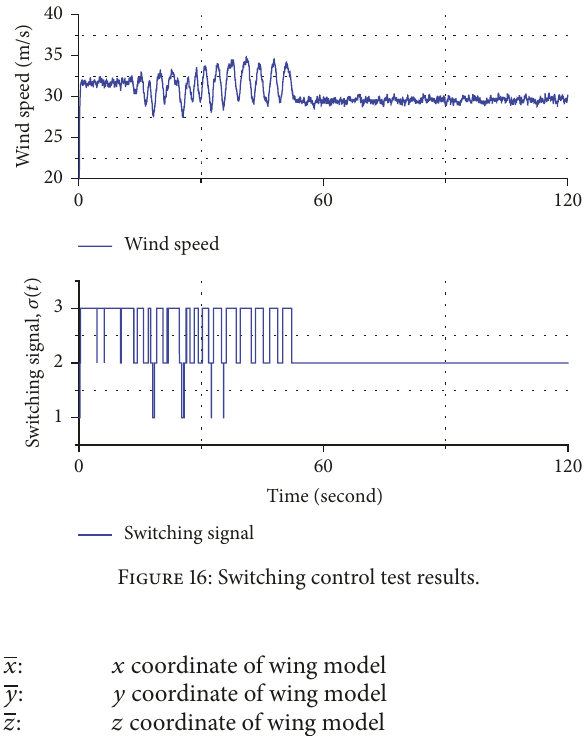
Figure 13: Comparison between the root locus of open-loop and closed-loop systems.